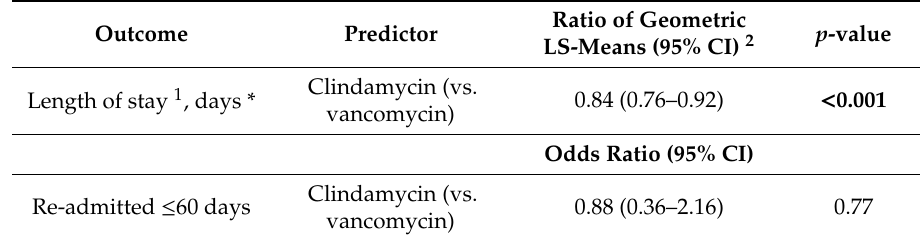
Table 5. Adjusted analysis of outcomes based on initial antibiotic